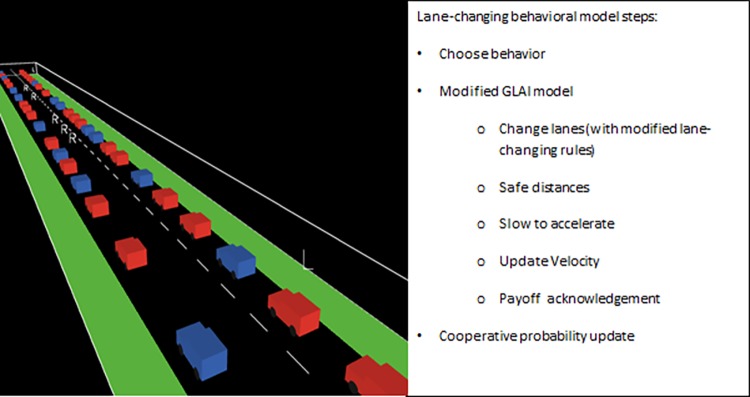
3D view (left) and steps (right) of the presented model.The model is available for running on a browser and downloading (source code included) at https://sourceforge.net/projects/traffic-games/.